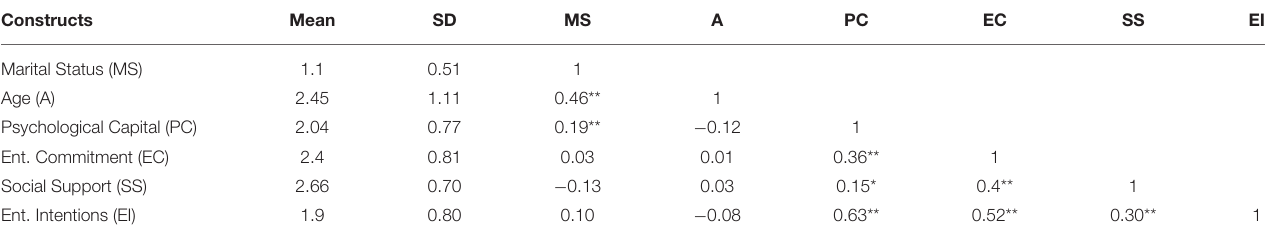
TABLE 1 | Correlation analysis. Constructs